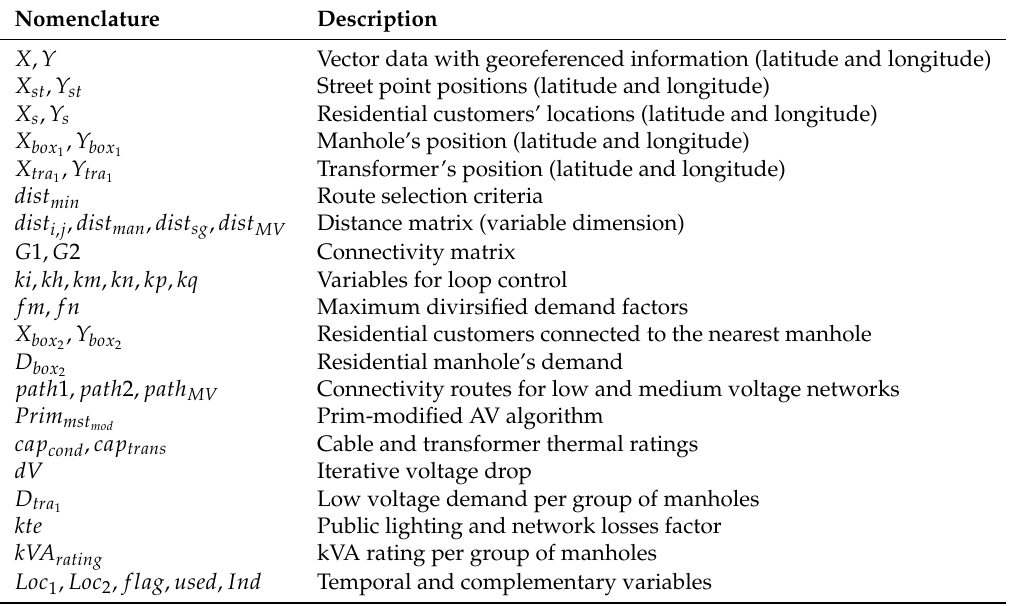
Table 3. Parameter and